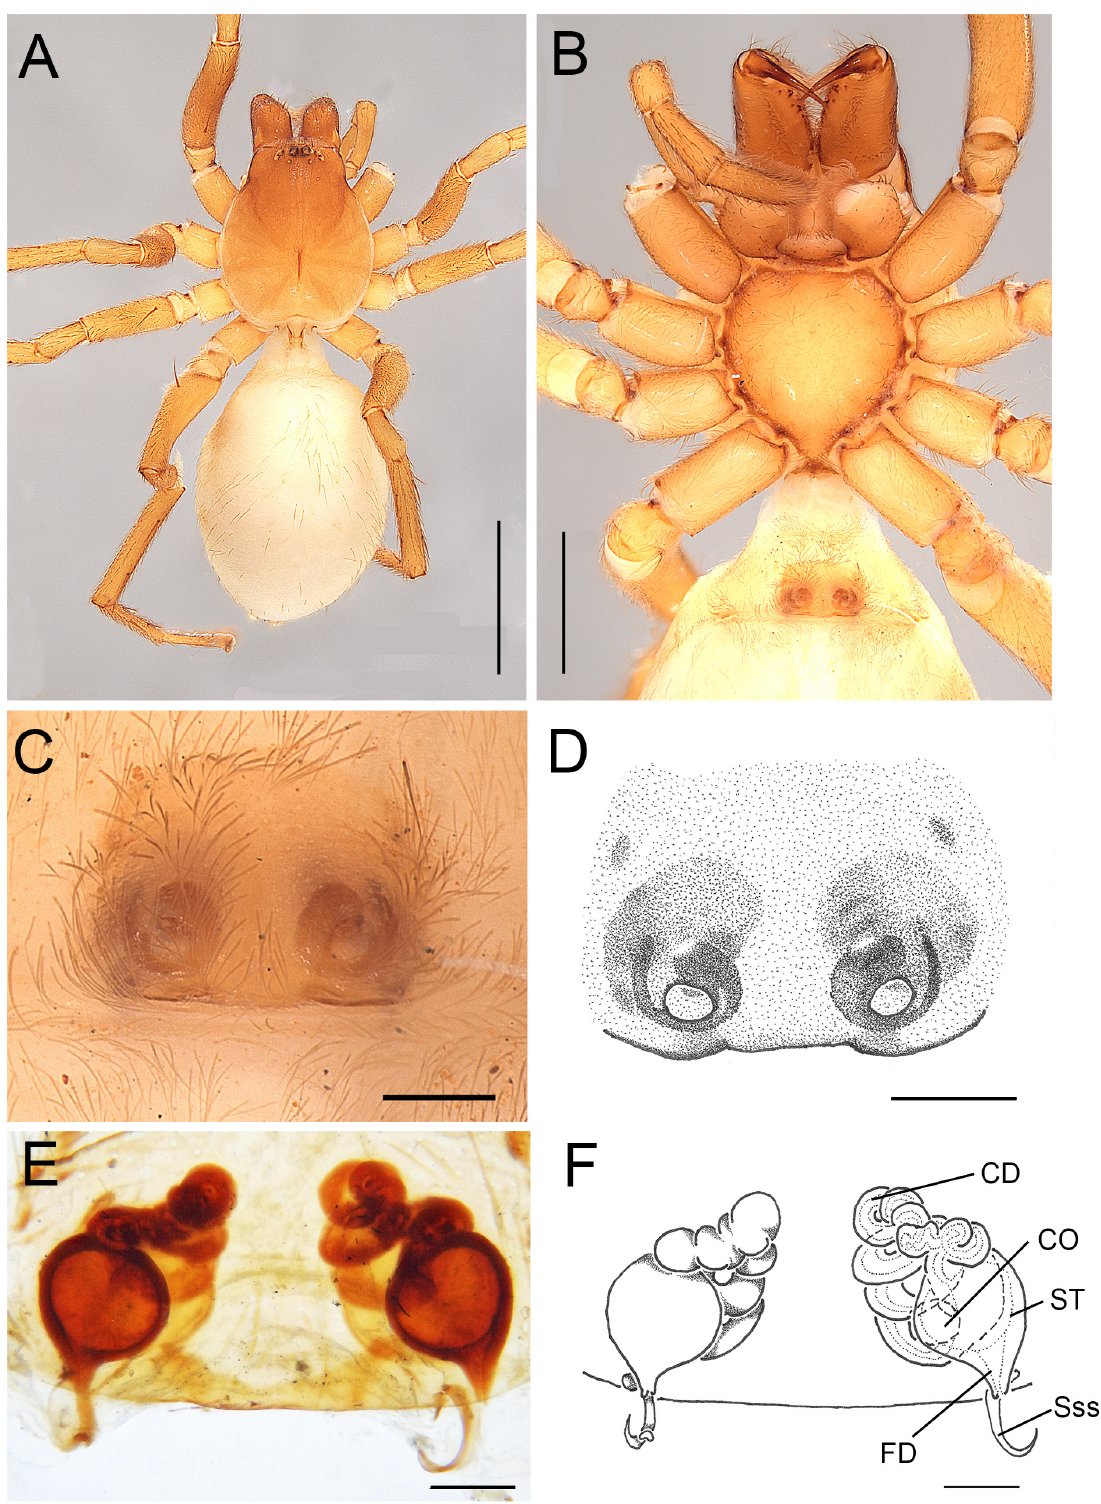
Fig. 29. Andromma katangensis sp. nov., ♀, holotype (BE_RMCA_ARA.Ara 90890). A . Habitus, dorsal view. B . Cephalothorax, ventral view. C–D . Epigyne, ventral view. E–F . Same cleared, dorsal view. Abbreviations: CD = copulatory duct; CO = copulatory opening; FD = fertilisation duct; Sss = sickle shaped sclerites; ST = spermatheca. Scale bars: A = 2 mm; B = 1 mm; C–D = 0.2 mm; E–F = 0.1